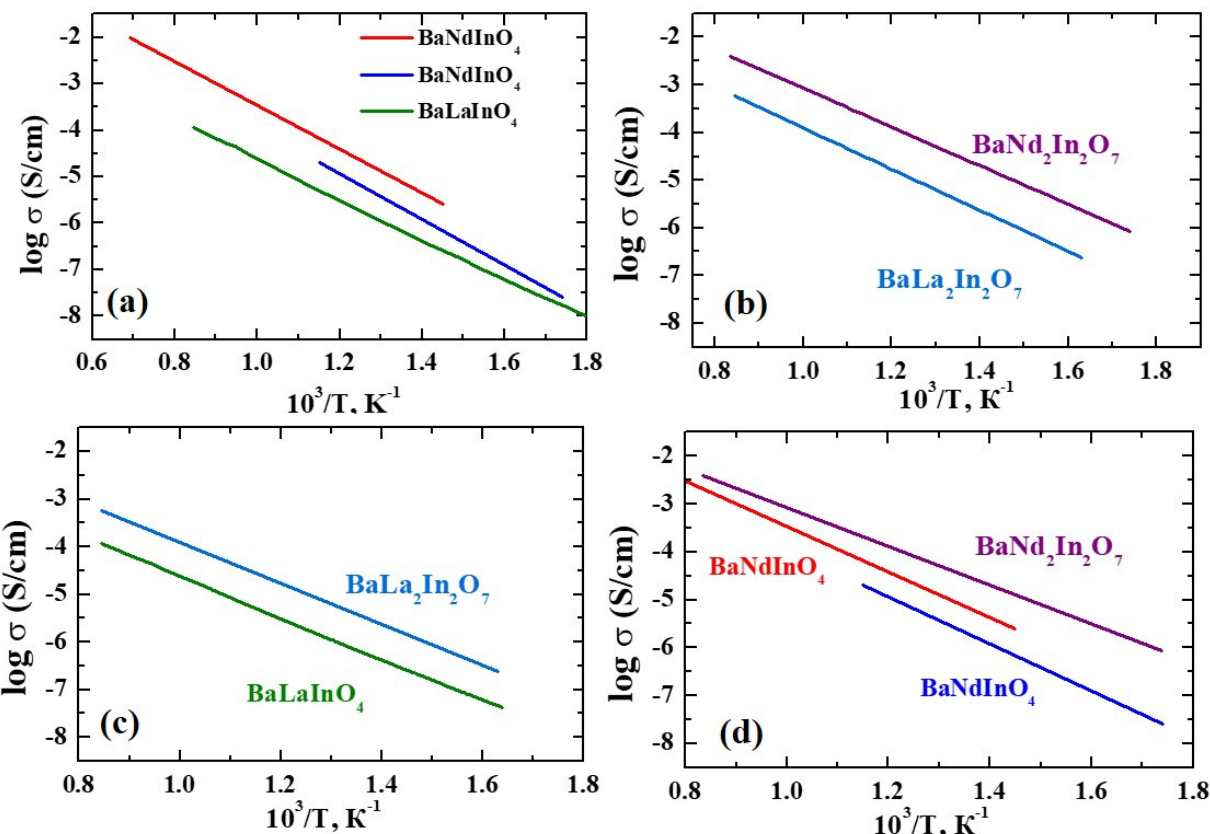
Figure 4. The temperature dependencies of electrical conductivity values obtained under dry air for monolayer BaLaInO 4 [74], BaNdInO 4 [70,71] compositions ( a ), two-layer BaLa 2 In 2 O 7 [74] and BaNd 2 In 2 O 7 [75] compositions ( b ), La-containing BaLaInO 4 [74] and BaLa 2 In 2 O 7 [74] compositions ( c ), Nd-containing BaNdInO 4 [70,71] and BaNd 2 In 2 O 7 [75] compositions ( d ).